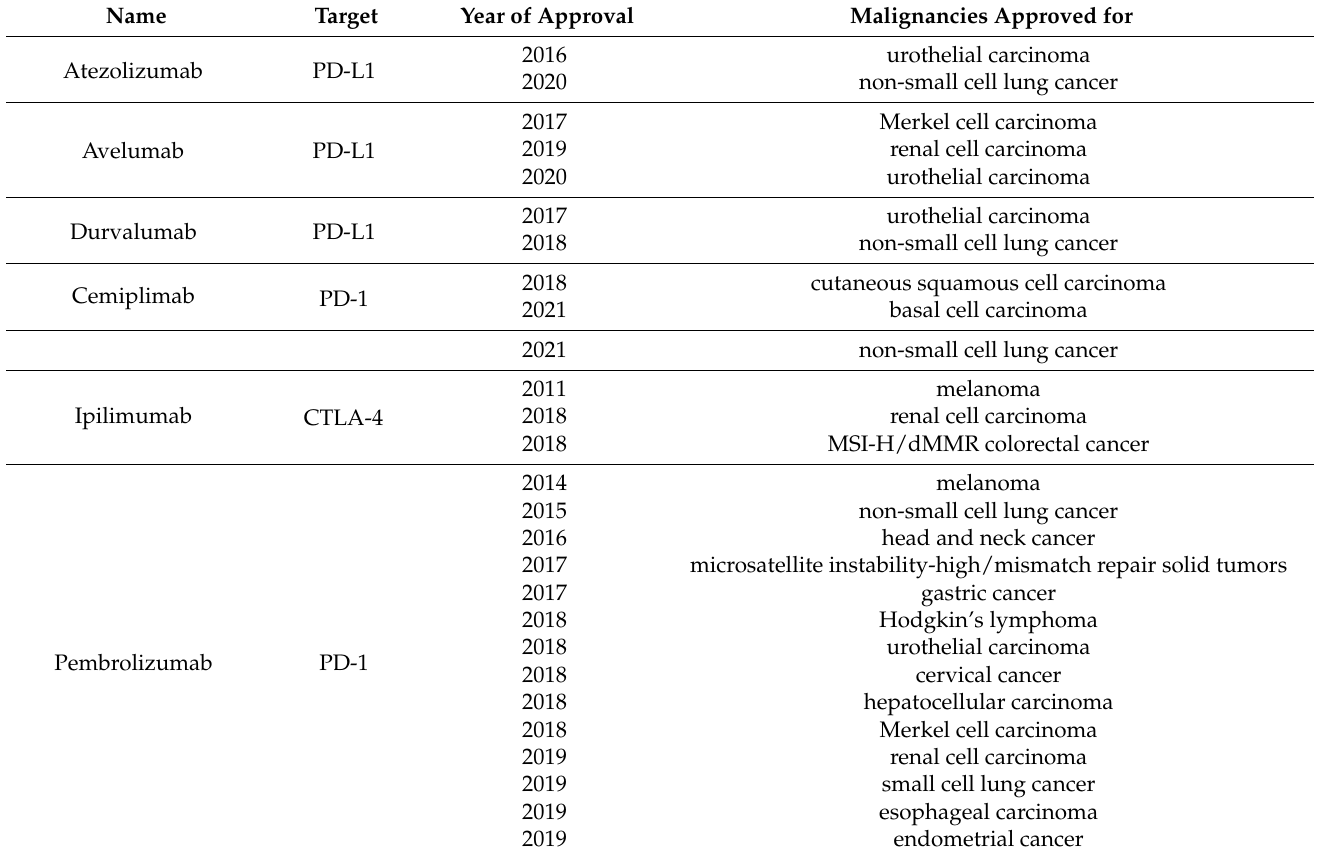
Table 1. List of currently approved